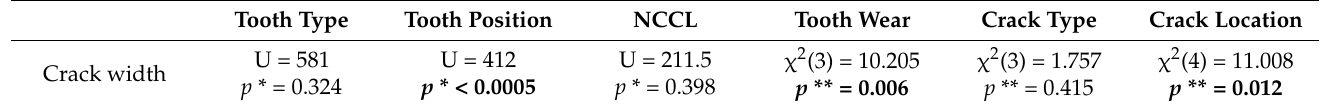
Table 4. Statistical results regarding the analysis of cracks’ width according to various groups of teeth (* Mann–Whitney U test; ** Kruskal–Wallis H